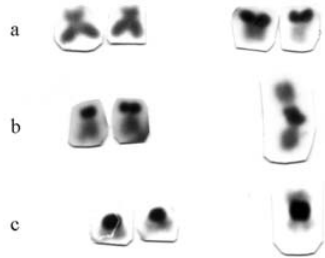
Figure 5 - NOR-bearing chromosomes. (a) Calyptommatus leiolepis giemsa and silver stained chromosome pair 27. (b) Psilophthalmus paeminosus Ag-NOR bearing microchromosome pair showing associa- tion on the right side. (c) Tretioscincus oriximinensis Ag-NOR bearing microchromosome pair showing association on the right